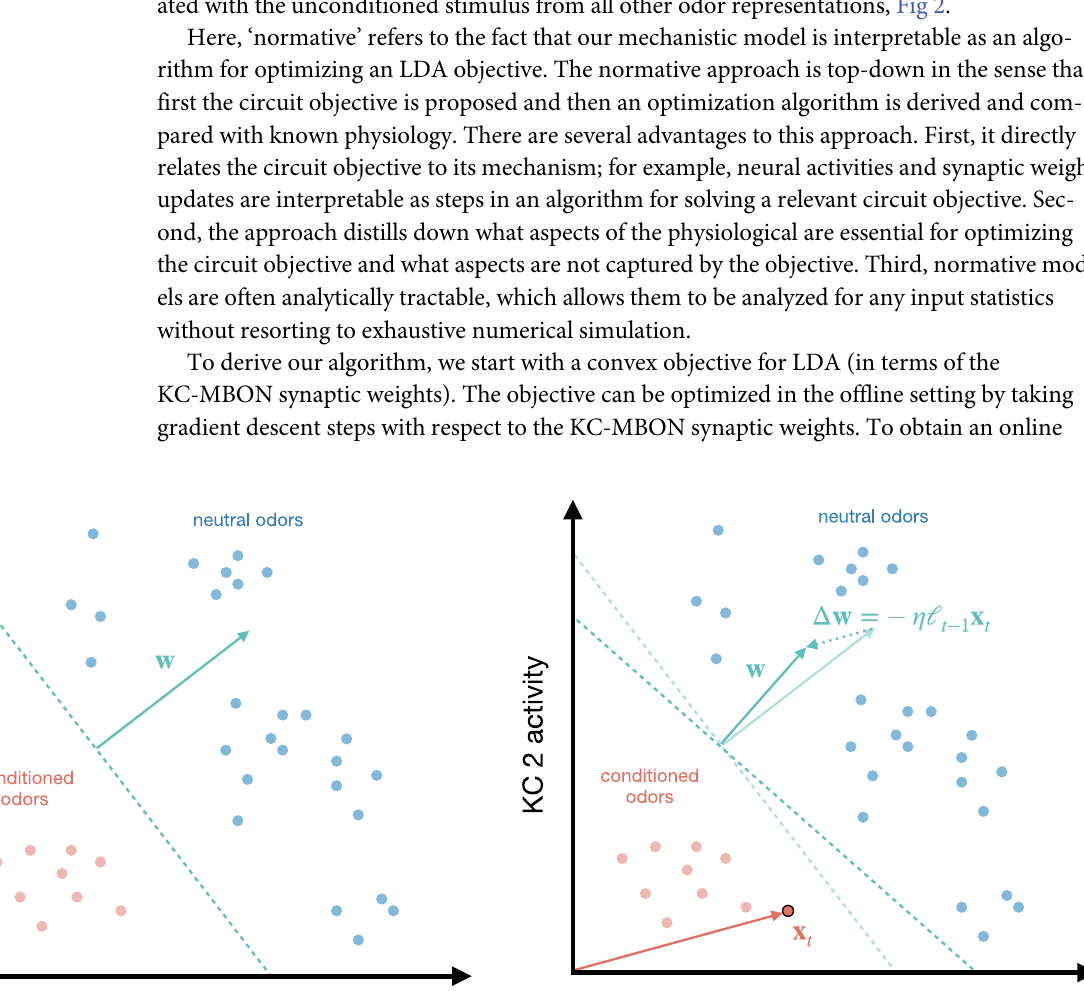
PLOS Computational Biology | https://doi.org/10.1371/journal.pcbi.1010864 February6,